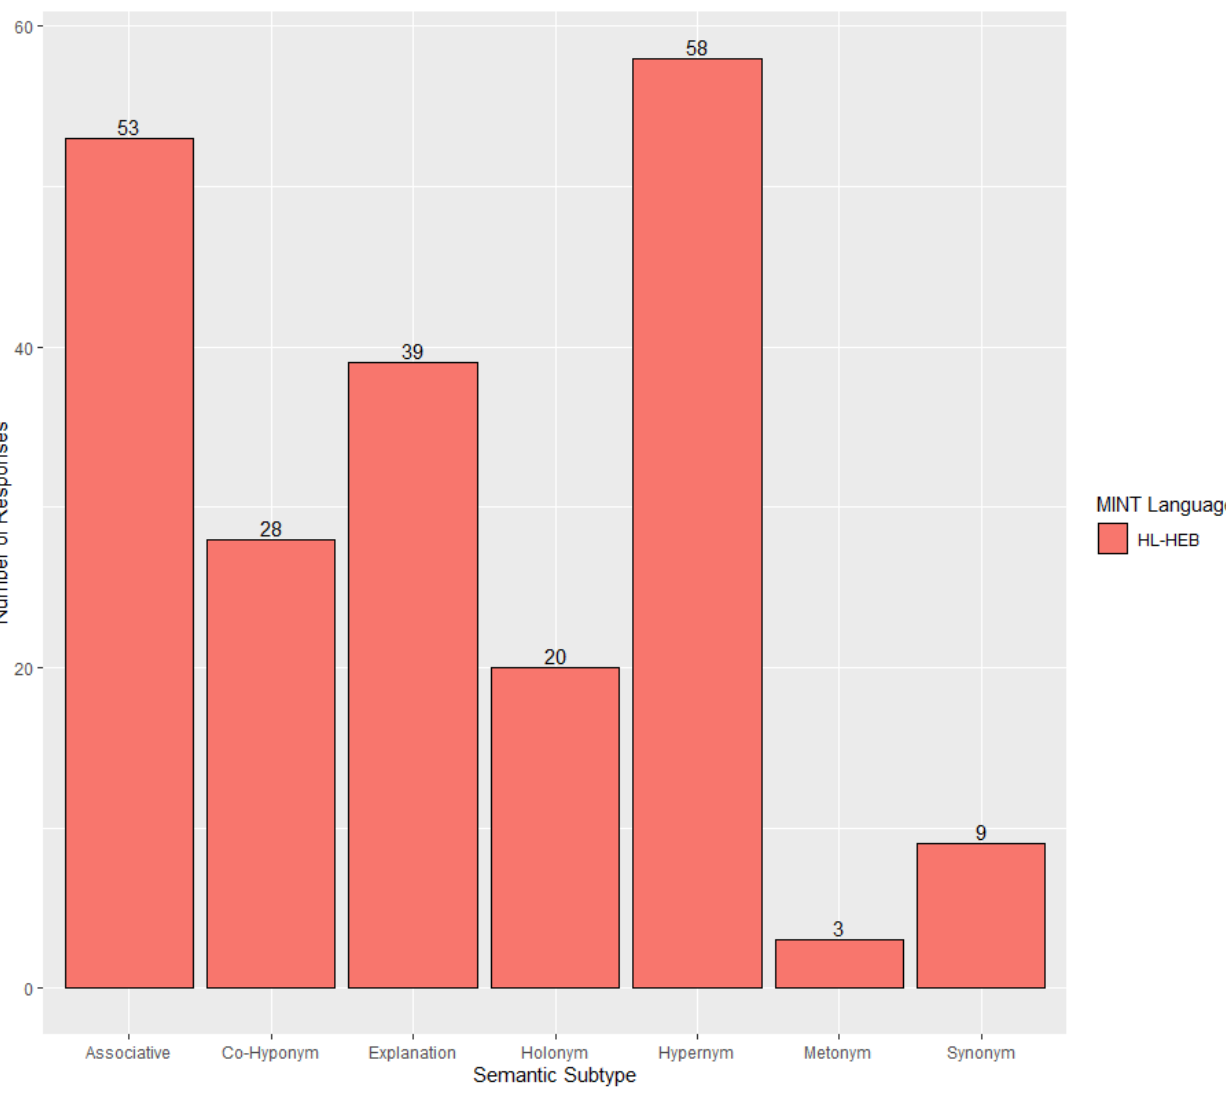
Figure 3. Semantic Non-target Response Types. Table 2. Cross-linguistic Non-target Responses by